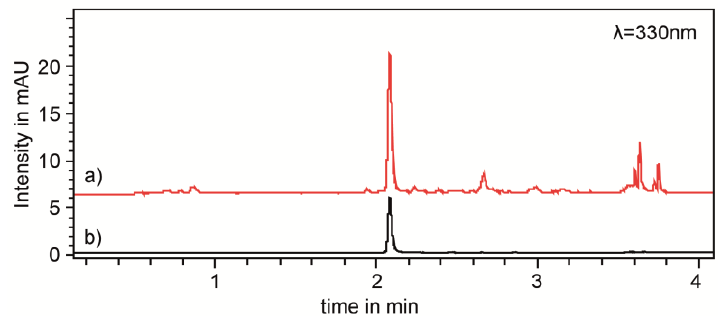
Figure 1. Chromatograms of ( a ) rosemary extract (red line) in 70% v / v ethanol (50 g/L) after 3 h continued stirred extraction, and ( b ) rosmarinic acid reference solution (black line), measured at 330 nm.